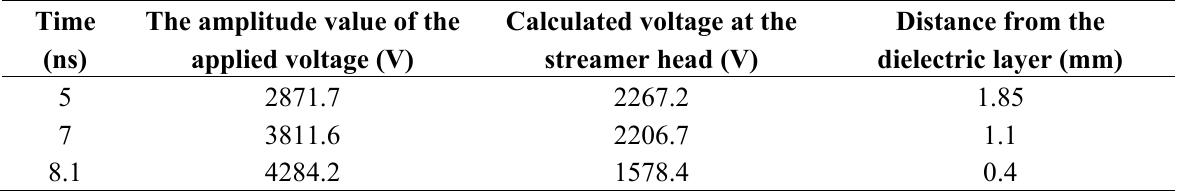
Table 4. The amplitude value of the applied voltage, the voltage at the streamer head and the distance from the dielectric layer at different times for SNG.